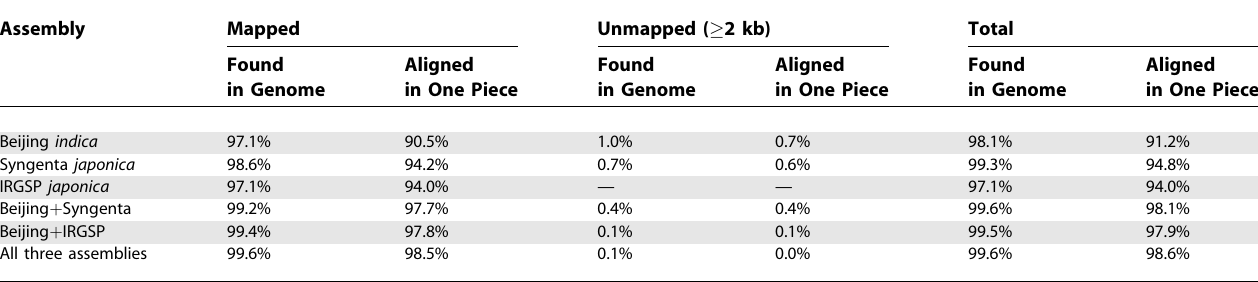
Table 2. Summary of nr-KOME cDNAs with Complete Alignments (Not Including UTRs) in Each of the Three Rice Assemblies Assembly Mapped